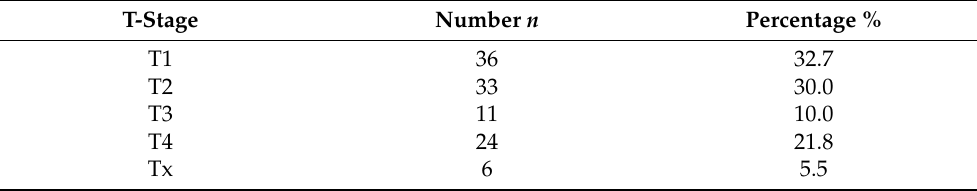
Table 2. Distribution of T- stages at initial diagnosis (based on eighth UICC TNM Classification).